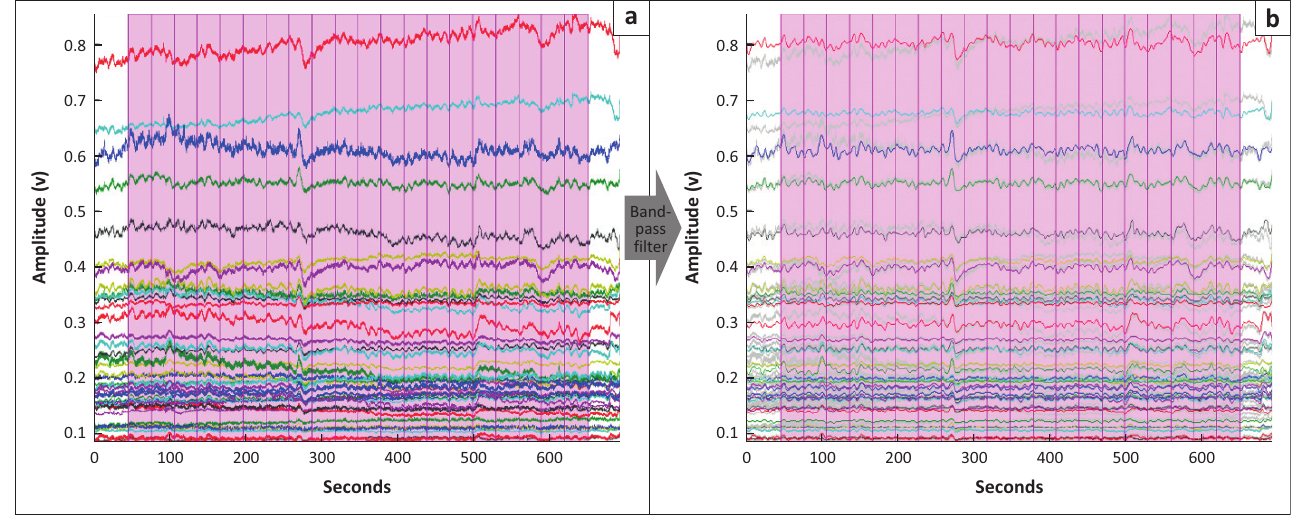
FIGURE 6: Band-pass filter illustration. (a) functional near-infrared spectroscopy (fNIRS) raw data. Each line represents the signal from one channel. (b) The raw and filtered data. The shaded curve is the raw data and the darker curve is the filtered data. An example of a filter application. For illustration purposes, a band-pass filter with the features of roll off width ( % ) =15 15, low cut-off frequency (Hz) = 0.01 and high cut-off frequency (Hz) = 0.2 was applied to the fNIRS light intensity. This step is performed before the application of the Beer–Lambert law to change it to oxygenated haemoglobin and deoxygenated